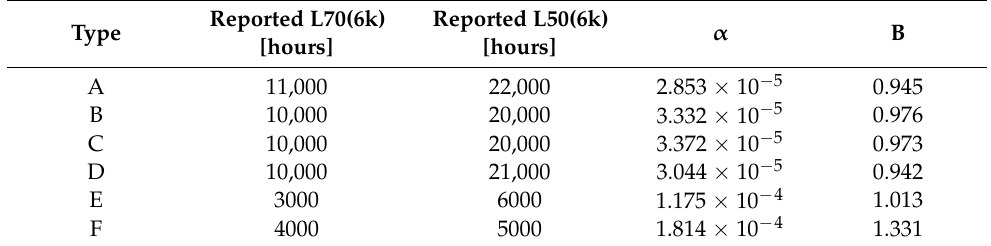
Table 4. Evaluated lifetime of OLED panels and luminaires with operating of six thousand